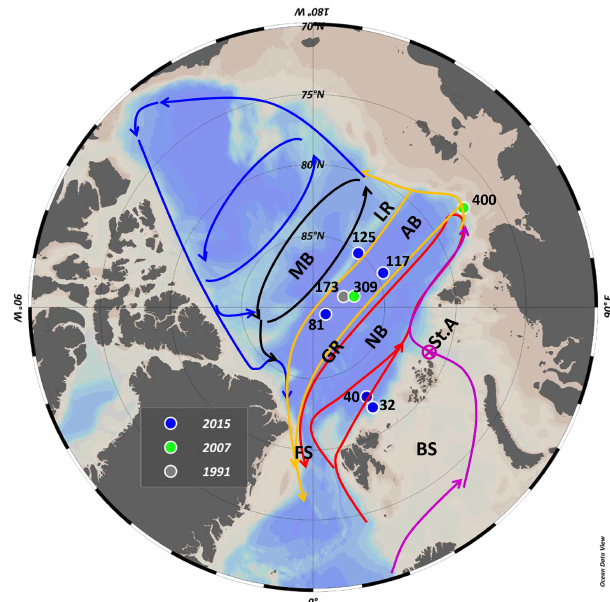
Figure 1. Map of the Arctic Ocean and station overview. AB: Amundsen Basin; NB: Nansen Basin; GR: Gakkel Ridge; MB: Makarov Basin. BS: Barents Sea; FS: Fram Strait; LR: Lomonosov Ridge; St.A: St. Anna Trough with intermediate water circulation patterns after Rudels (2009). Red is the Atlantic inflow through Fram Strait (FSBW) and return flow through the Nansen Basin; pur- ple is the inflow through the Barents Sea (BSBW). Atlantic layer circulation in the Amundsen Basin (orange), the Makarov Basin (black) and Canada Basin (blue) are indicated as arrows. Copyright: Schlitzer